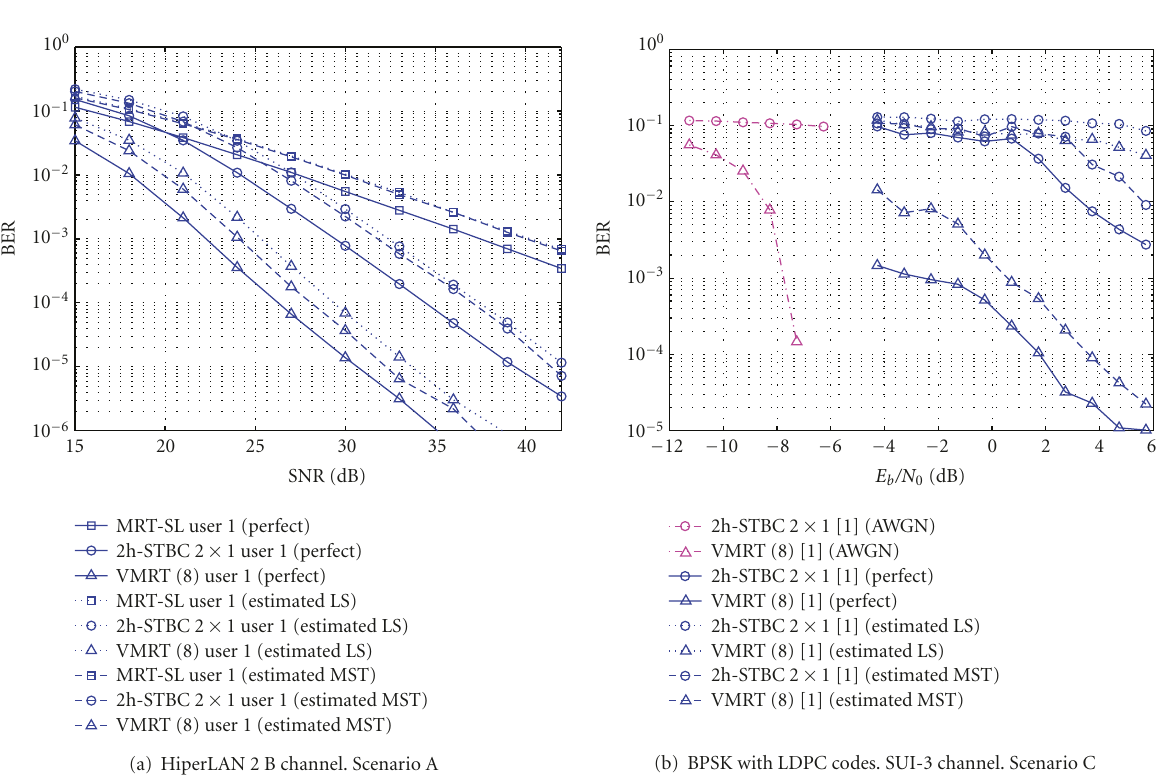
Figure 4: Performance results: e ff ect of channel estimation; N t = 4, N RS = 8, N u = 4, N VMRT =